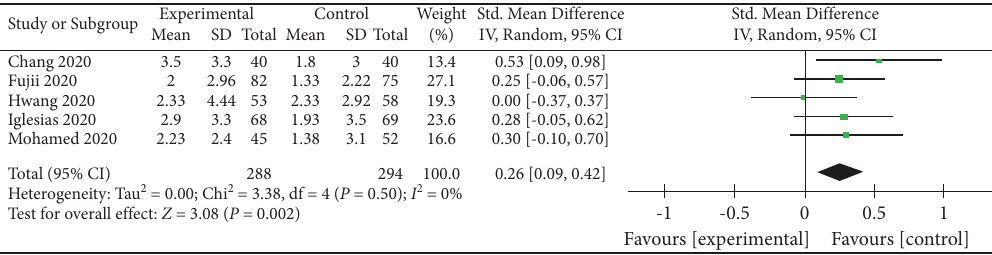
Figure 15: Forest plots for the efect of vitamin C on ∆ SOFA